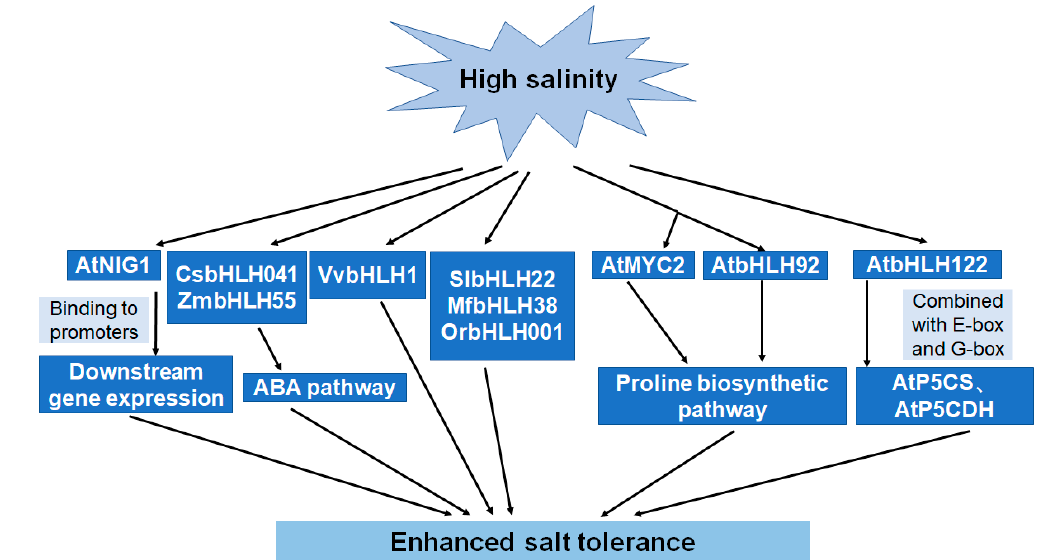
Figure 2. Model of the roles of bHLHs in salt tolerance.